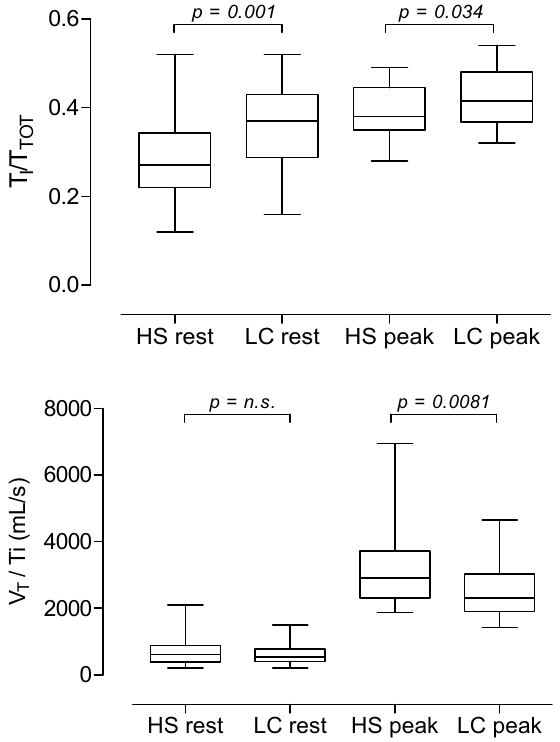
Figure 1. Mean, SD and range values of T I /T TOT at rest and at peak of exercise in 40 healthy subjects and 42 Long-COVID patients ( upper panel ) and mean, SD and range values of V T /T I at rest and at peak of exercise in 40 healthy subjects and 42 Long-COVID patients ( lower panel ).